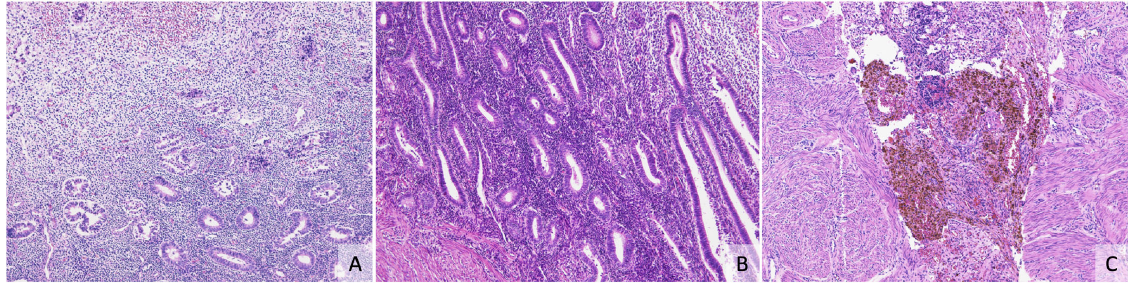
Fig. 2 Light microscopic views of the endometrium in the bicorporeal uterus. Histological fi ndings of the endometrium in the left side of the uterus (A) (100 X magni fi cation) and right side of the uterus (B). The right side of the uterus revealed hemorrhages on the surface of the myometrium with accumulation of hemosiderin with hematoxylin and eosin staining (100X magni fi